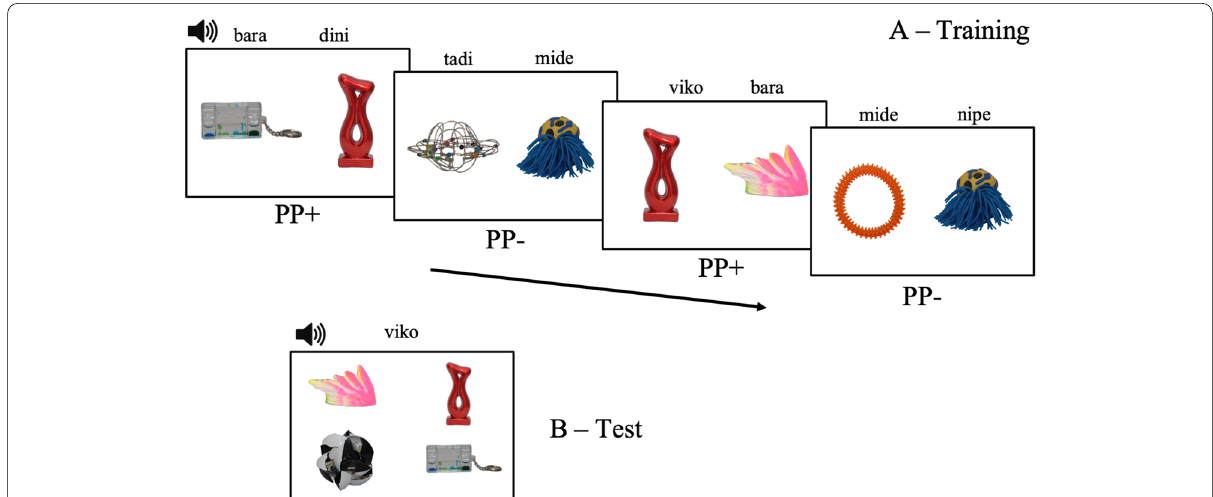
Fig. 1 A The Training phase with four 2